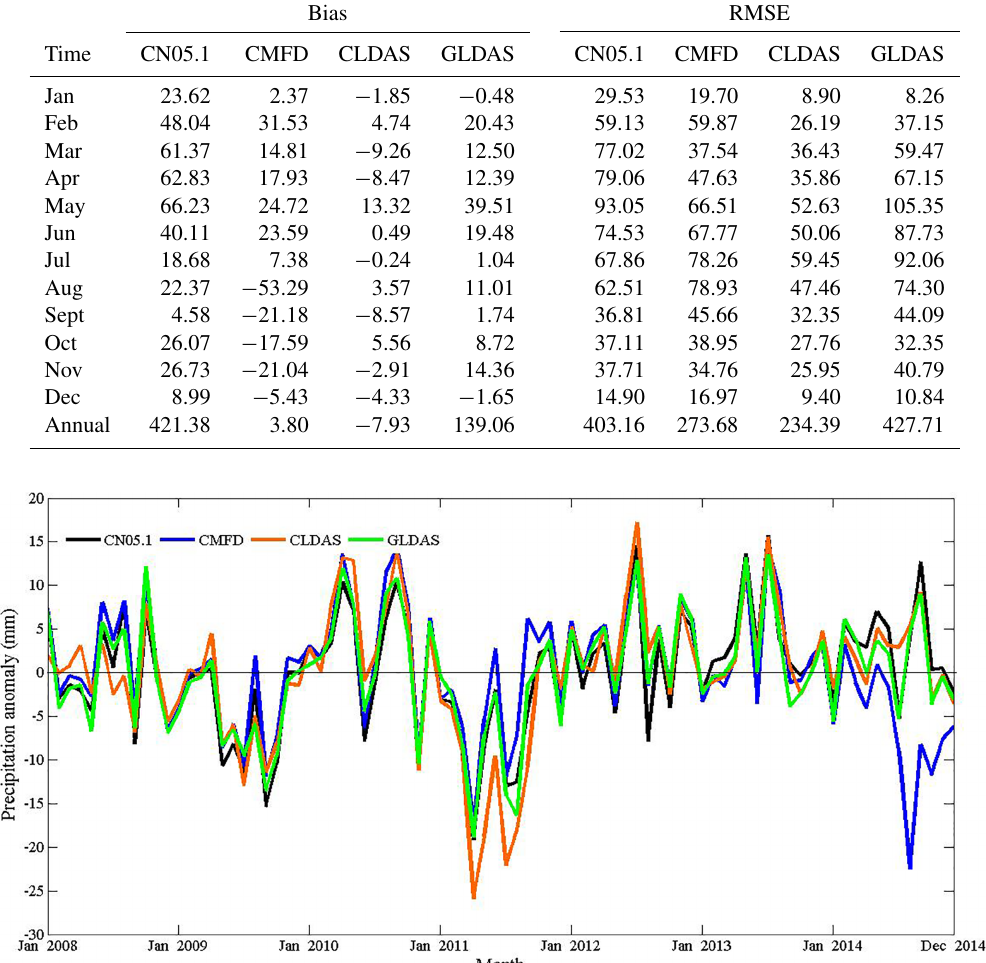
Table 4. Statistical metrics summarizing the performance of monthly precipitation estimates based on forcing data sets in 2014 relative to